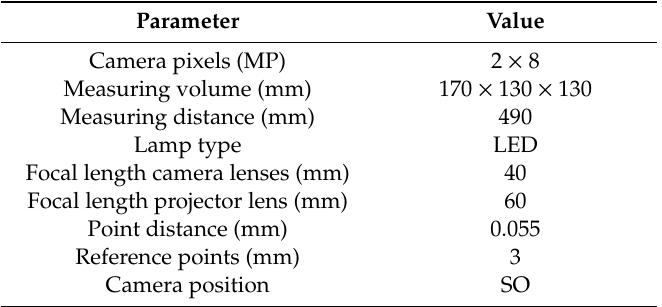
Table 2. Parameters of the 3D scanner GOM ATOS III Triple